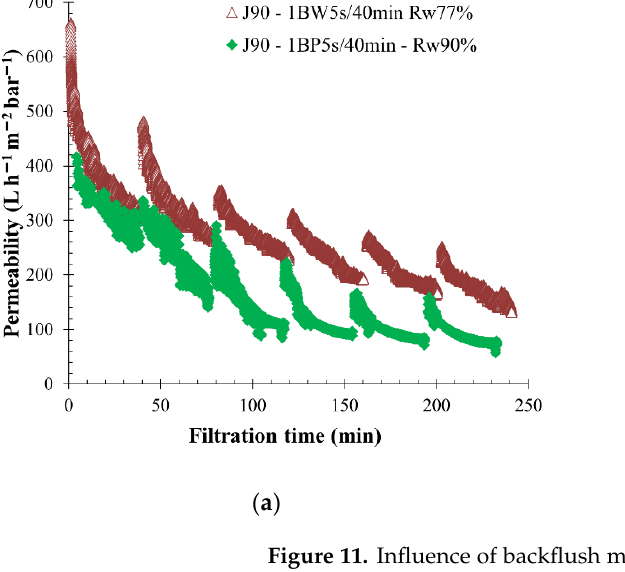
Figure 11. Influence of backflush mode (BP-BW) on membrane filtration behavior by variation of permeability at 20 ◦ C ( a ); fouling resistance ( b ) and the concentration factor over time with pressure water injected for 5 s every 40 min and a permeate flux of 90 L h − 1 m − 2 . Filtration is made with BW action (white triangle) and BP action (grey triangle). T = 20 ◦ C, feedwater from CC-KERGUELEN; SiC membrane 0.33 m 2 . Jxx is permeate flux at the xx value in L h − 1 m − 2 ; 1BW yy s/zz min where yy is the duration and zz the interval of filtration between two BF; and Rw is the total recovery rate applied on the unit; R irr is irreversible resistance; R rev is reversible resistance and R mbrn is the membrane